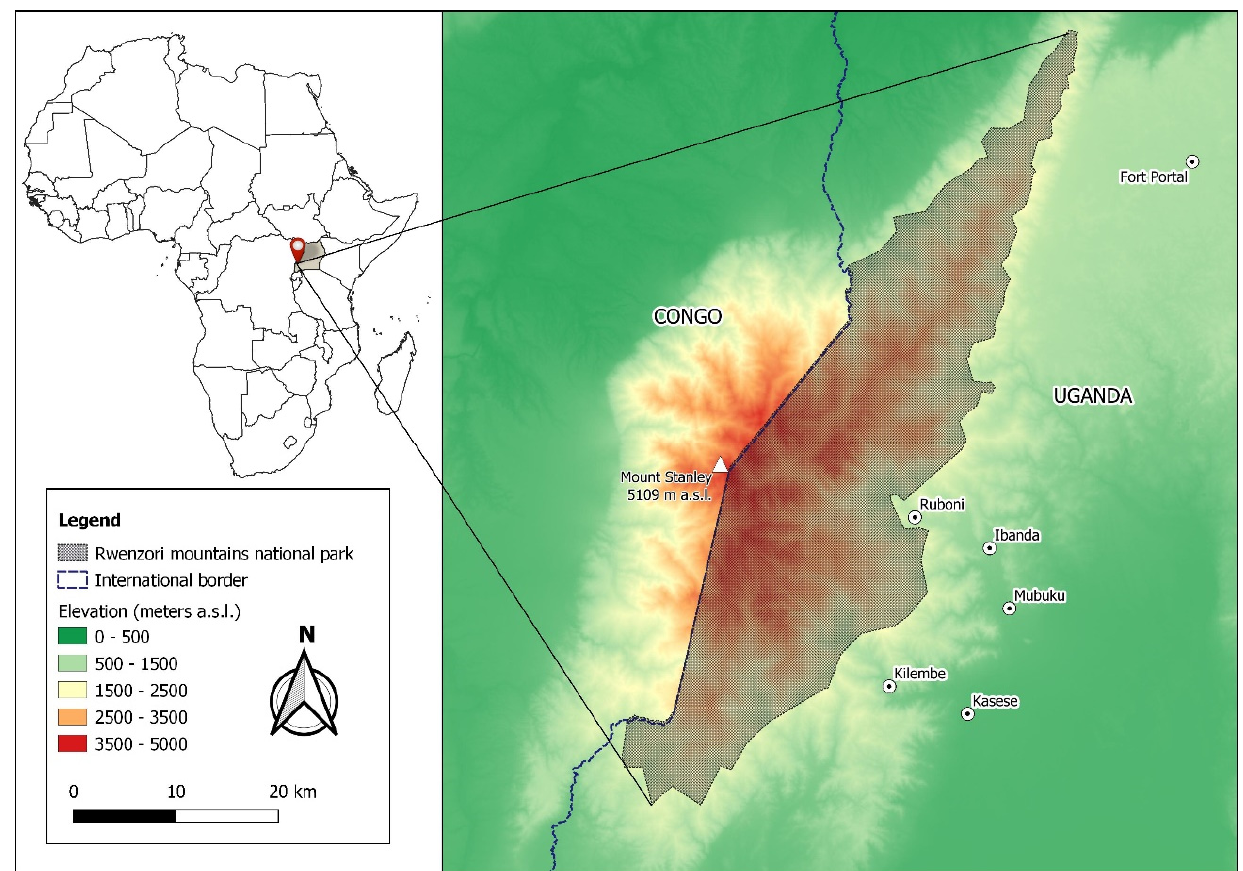
Figure 1. Map of Uganda showing the study area and its surrounding area.